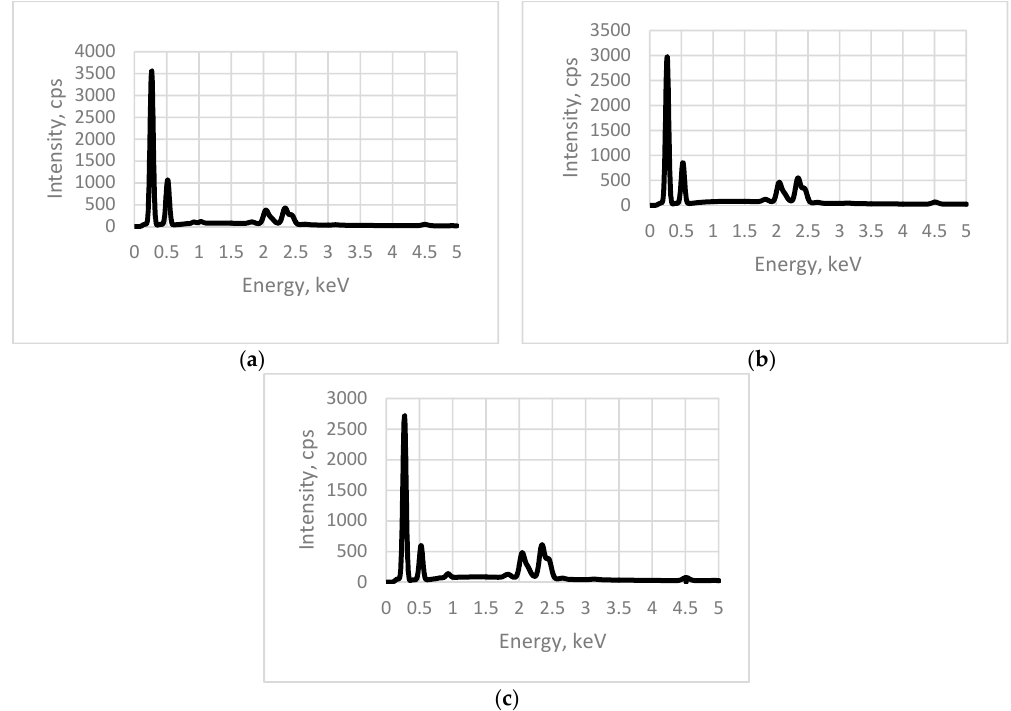
Figure 5. Energy dispersive spectrum of: ( a ) Element 1 (mesh 32/70); ( b ) Element 2 (mesh 48/70); ( c ) Element 3 (mesh 140/34).